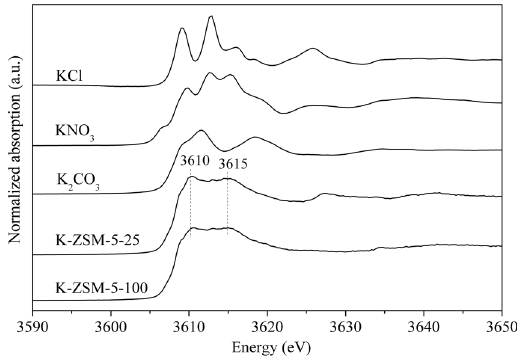
Figure 3. Normalized absorption of K K-edge for K-ZSM-5, K 2 CO 3 , KNO 3 and KCl.